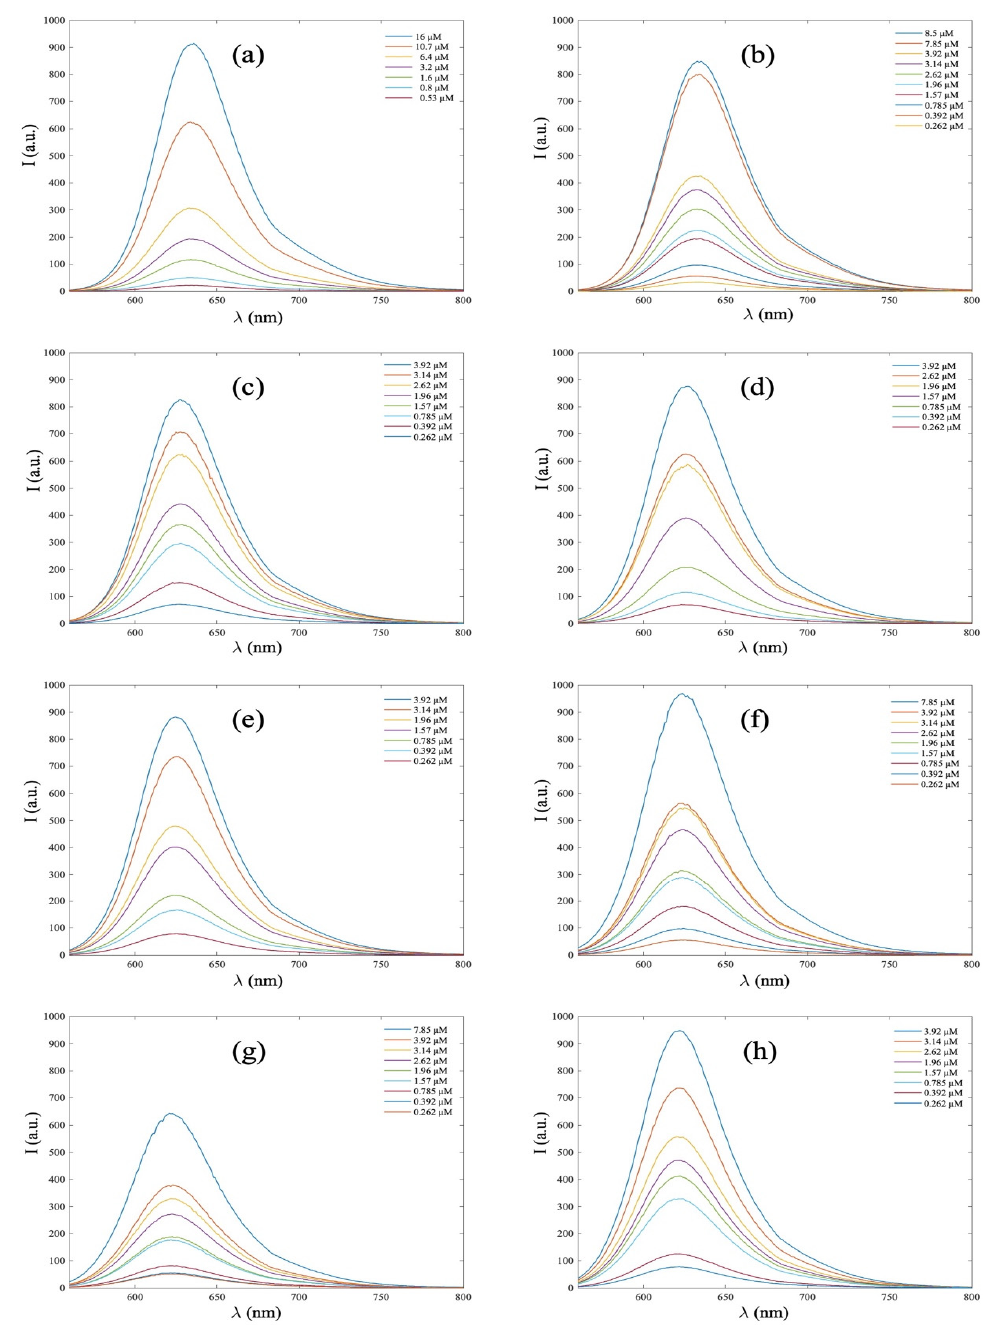
Figure 6. Fluorescence emission spectra of NR in ( a ) Methanol, ( b ) Ethan-1ol, ( c ) Propan-1ol, ( d ) Butan-1ol, ( e ) Pentan-1ol, ( f ) Hexan-1ol, ( g ) Heptan-1ol, and ( h ) Octan-1ol. The concentrations of the dilutions are in the range of 0.262–16 μ M.